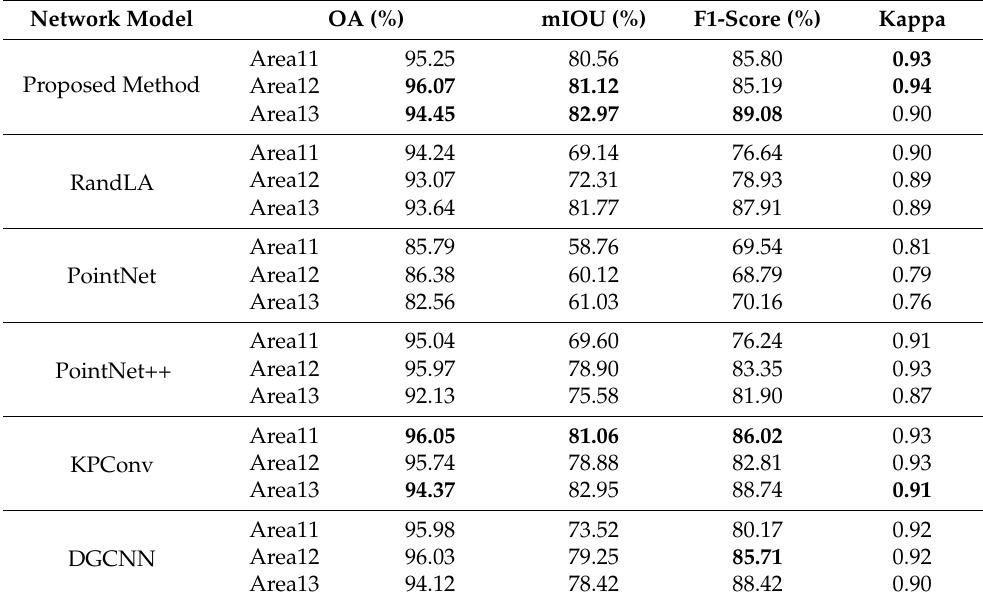
Figure 9. The Visualization output of different methodological models. Table 2. The results of evaluation metrics from different methodological models.